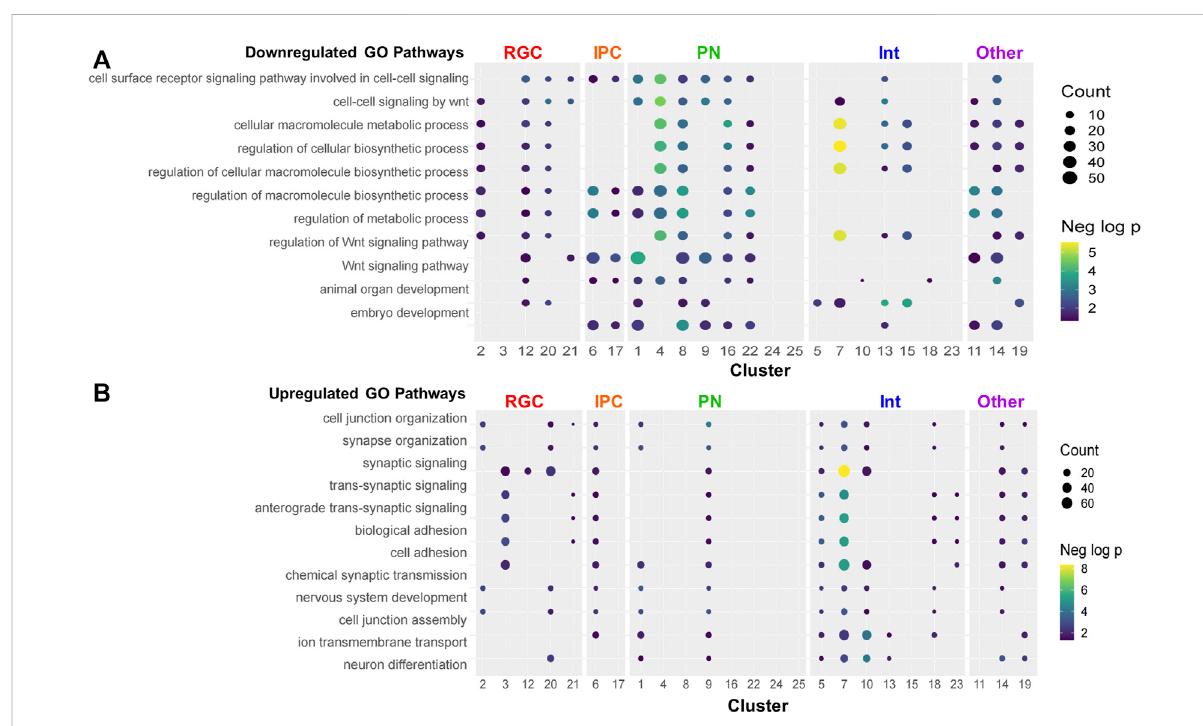
FIGURE 6 Gene ontology analysis of pathways altered by PAE. (A – B) Dot plot of the top repeating downregulated (A) and upregulated (B) pathways. Pathways were considered signi fi cant with a p -value < 0.05 and containing at least 3